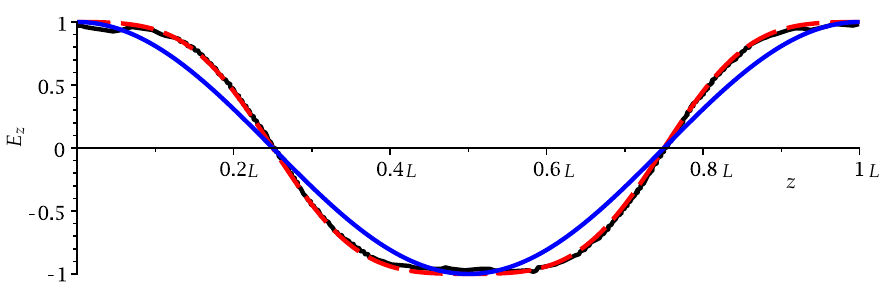
Figure 13. Profile of E z component for a waveguide with 2 × 2 infinitely long wires of varying radii (solid Black) in comparison with Mathieu function (dashed red) and sin function (blue). Here L = 127.4 mm. Both E z and the Mathieu function are normalised. However CST gave the maximum longitudinal field as 6.03 × 10 7 Vm − 1